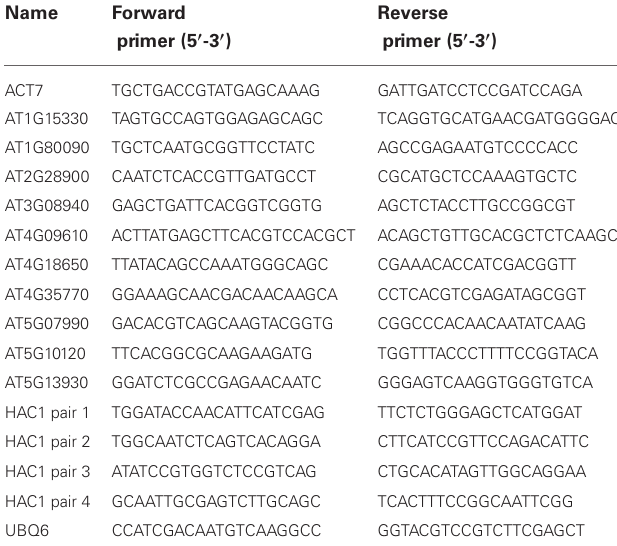
Table 1 | Primer sets used for